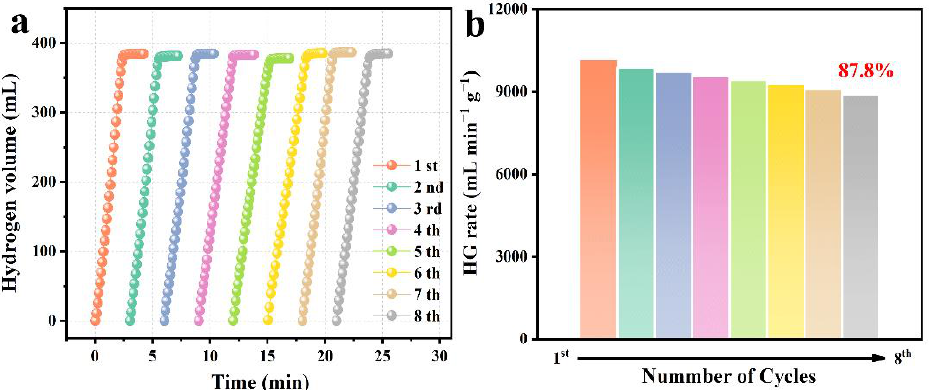
Figure 9. ( a ) Reusability of PtNi/PTOC with 0.1 g catalyst and 1.5 wt% NaBH 4 + 5 wt% NaOH solu- tion at 25 °C; ( b ) HG rate bar chart of catalyst used 8 times.